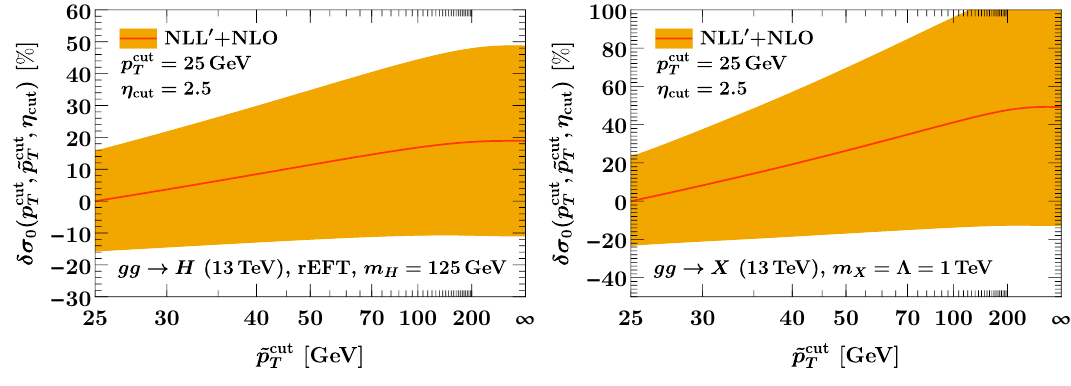
Figure 15 . 0-jet cross section (cid:27) 0 ( p cut panel) and gg X (right panel) at NLL 0 +NLO. The results are shown for a (cid:12)xed central veto ! at p cut